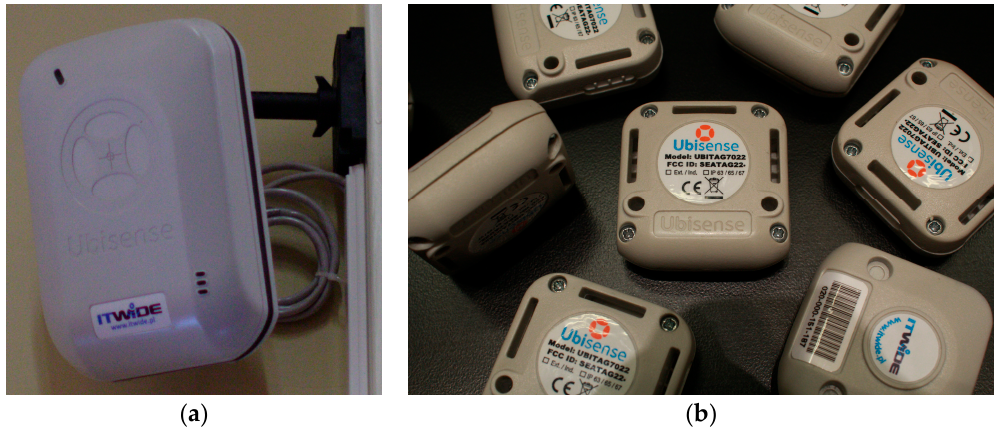
Figure 15. Photos of ( a ) RTLS sensor; ( b ) RTLS tags.